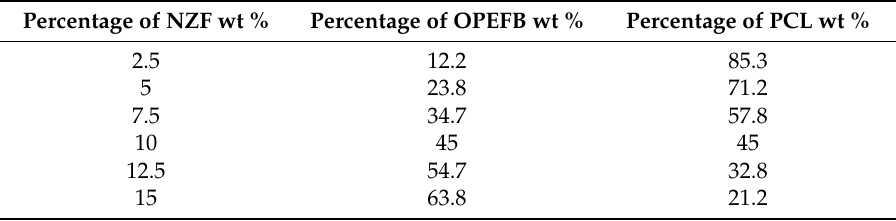
Table 1. Percentage of materials in the